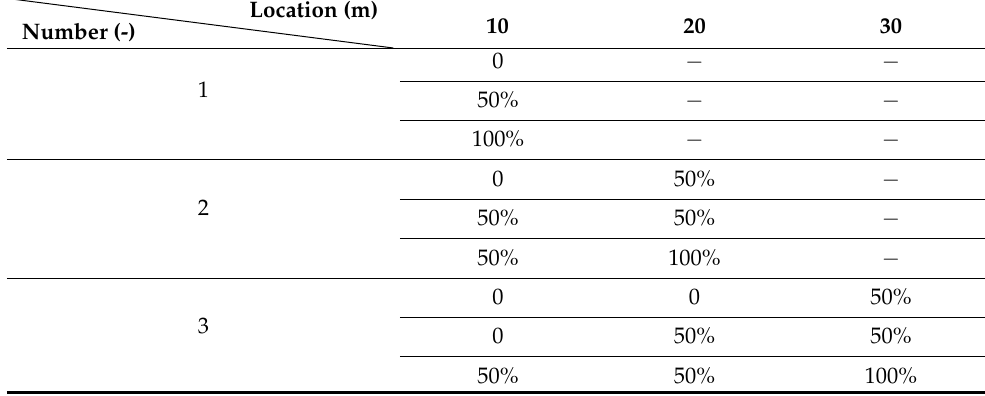
Figure 3. Obstruction growth rate (radius versus time) and tube blockage percentage (%) by the obstruction. Table 1. Scenarios of obstruction number, installation location, and inflation degree at each location.